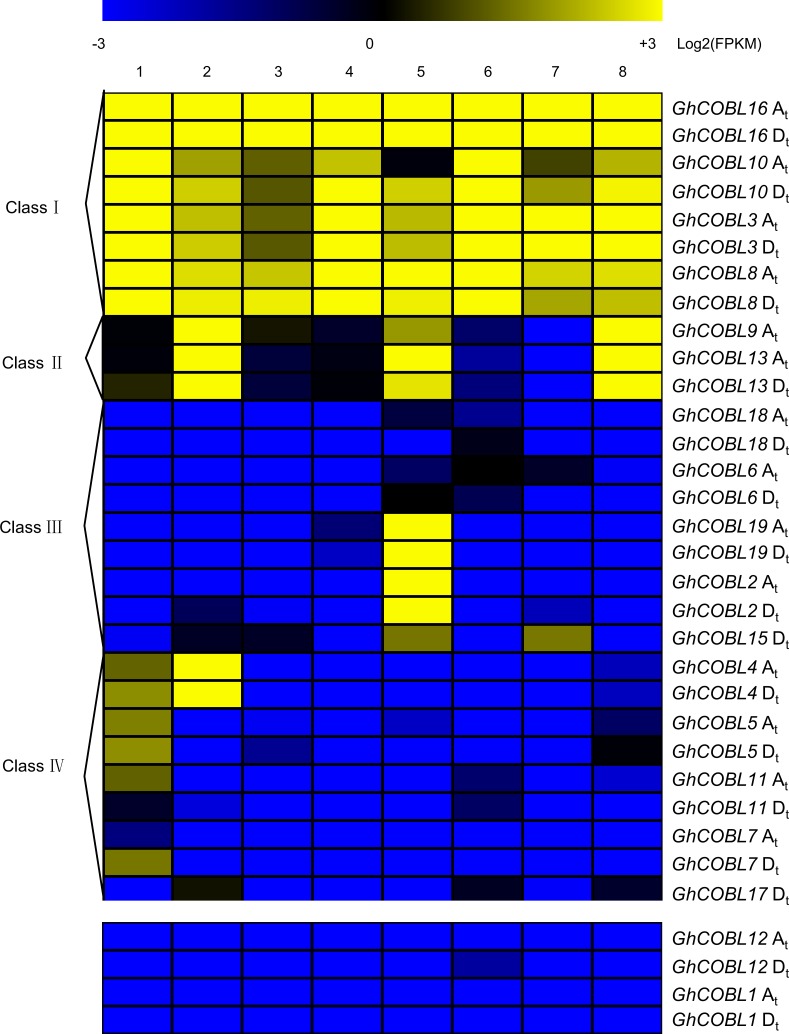
Heat map of the COBLs expression in different tissues of G. hirsutum acc. TM-1.The eight different tissues of G. hirsutum acc. TM-1 were involved here: 1: root; 2: stem; 3: leaf; 4: petal; 5: anther; 6: 0 DPA ovule; 7: 10 DPA fiber; 8: 20 DPA fiber. Log2 (FPKM) indicated the different transcriptome profiling (FPKM: fragments per kb per million mapped reads). At and Dt were derived from the A-genome and D-genome progenitor in the tetraploid cotton.